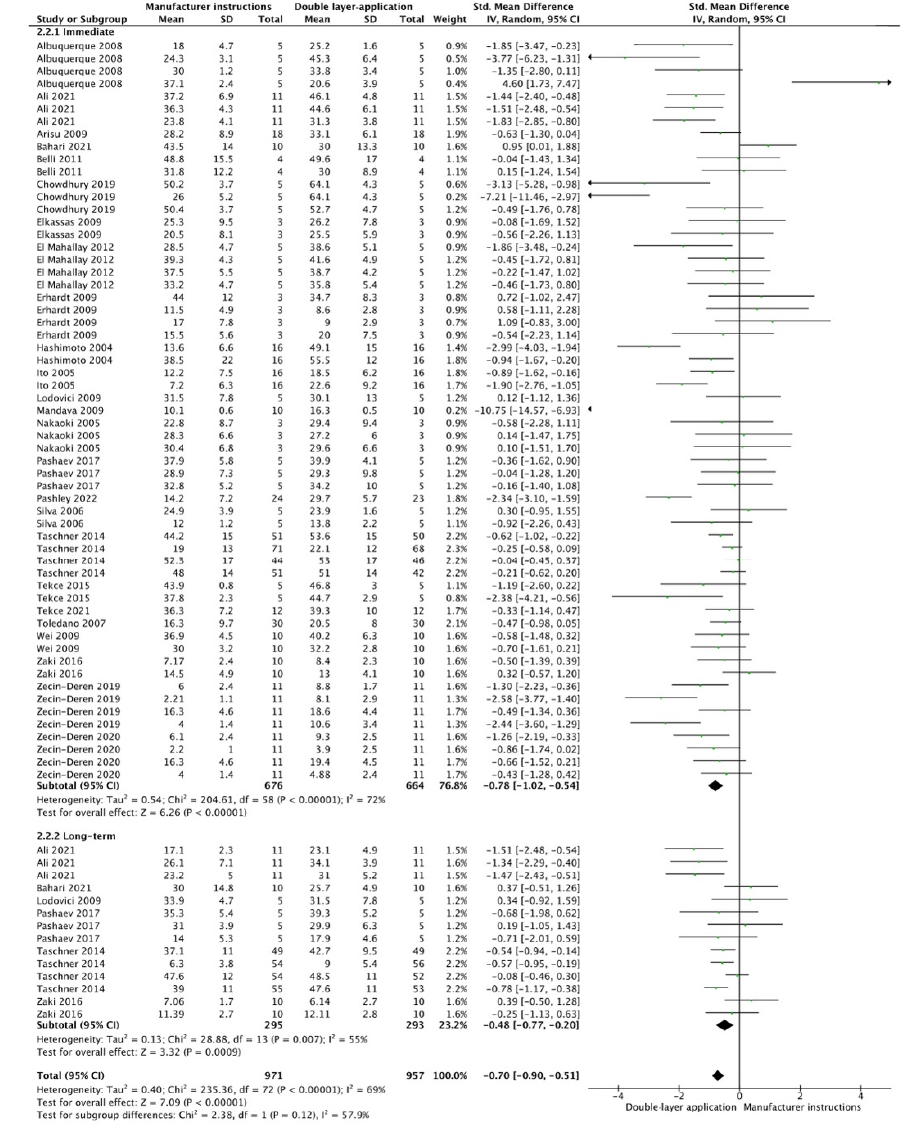
Figure 10. Forest plot showing the bond strength values when the adhesive was applied in two consecutive layers [63,69,72,75,77,78,92,93,96–111].